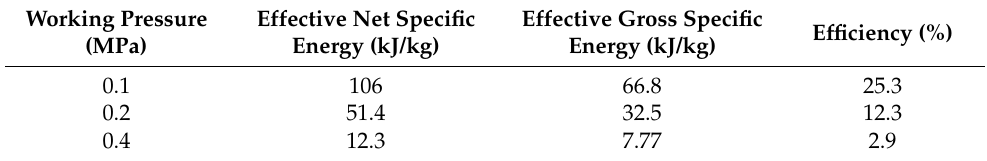
Table 4. Net and gross specific energies and calculated efficiency of the same compressor and battery setup at different working pressures, based on